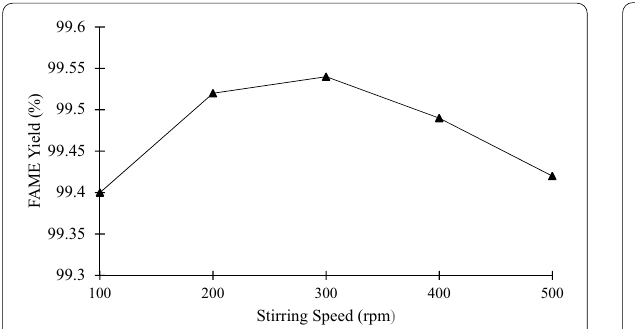
99.3299.34 Fig. 11 Graph of FAME purity against crystallization